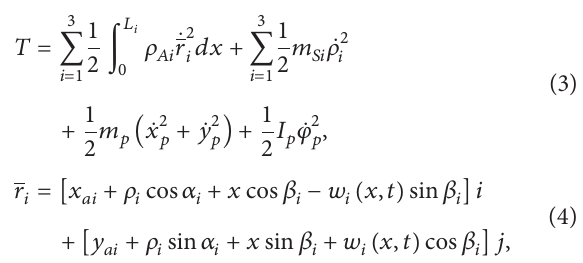
The total kinetic energy of the PPM is presented